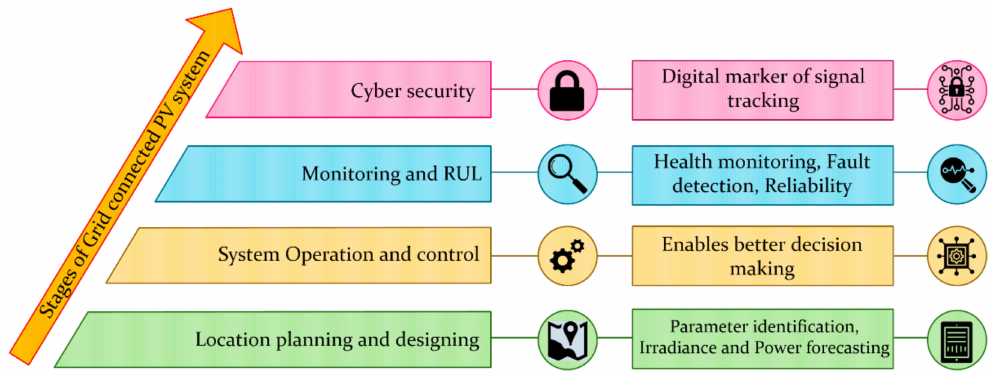
Figure 4. Digital transformation of grid-connected PV systems with AI. Table 1. Drawbacks of conventional algorithms for different applications and their solution with AI. Conventional